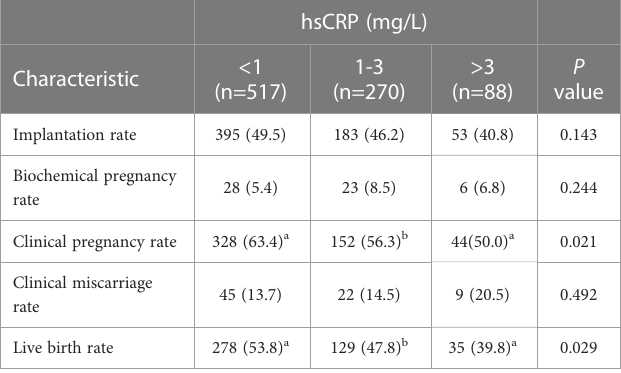
TABLE 3 IVF outcomes of women with low, moderate and high hsCRP.